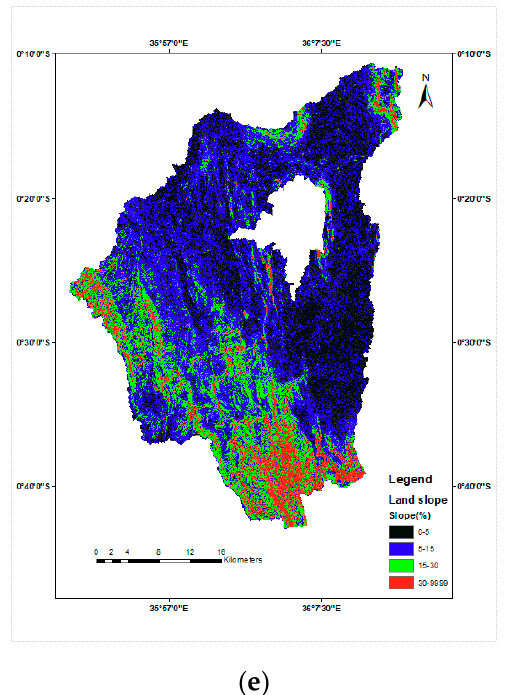
Figure 4. The digital elevation model ( a ) sub-basins ( b ); soil type ( c ), land use map ( d ), and slopes ( e ) for Lake Nakuru catchment.